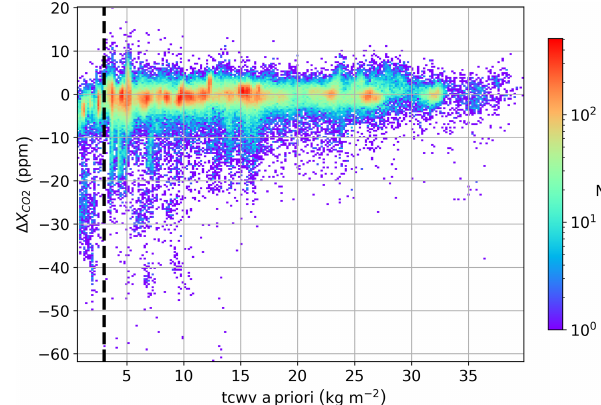
Figure 20. Bias in coincident retrievals of X CO – NNG), with no QC filtering against retrieved tcwv (total column water vapor), plotted as a density map. The lower bound placed on tcwv in the boreal QC (3kgm − 2 ) is shown as a black dashed vertical line.